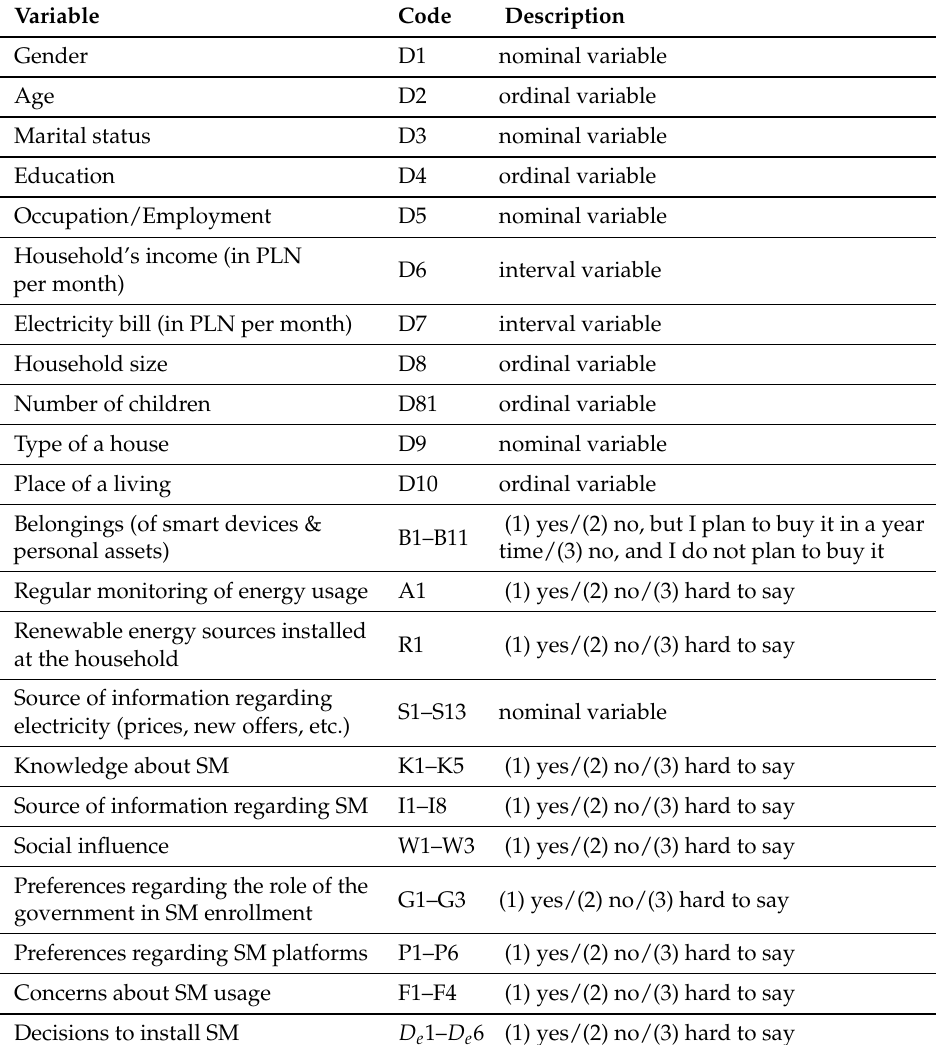
Table 1. Definitions of the variables and coding (N = 505).